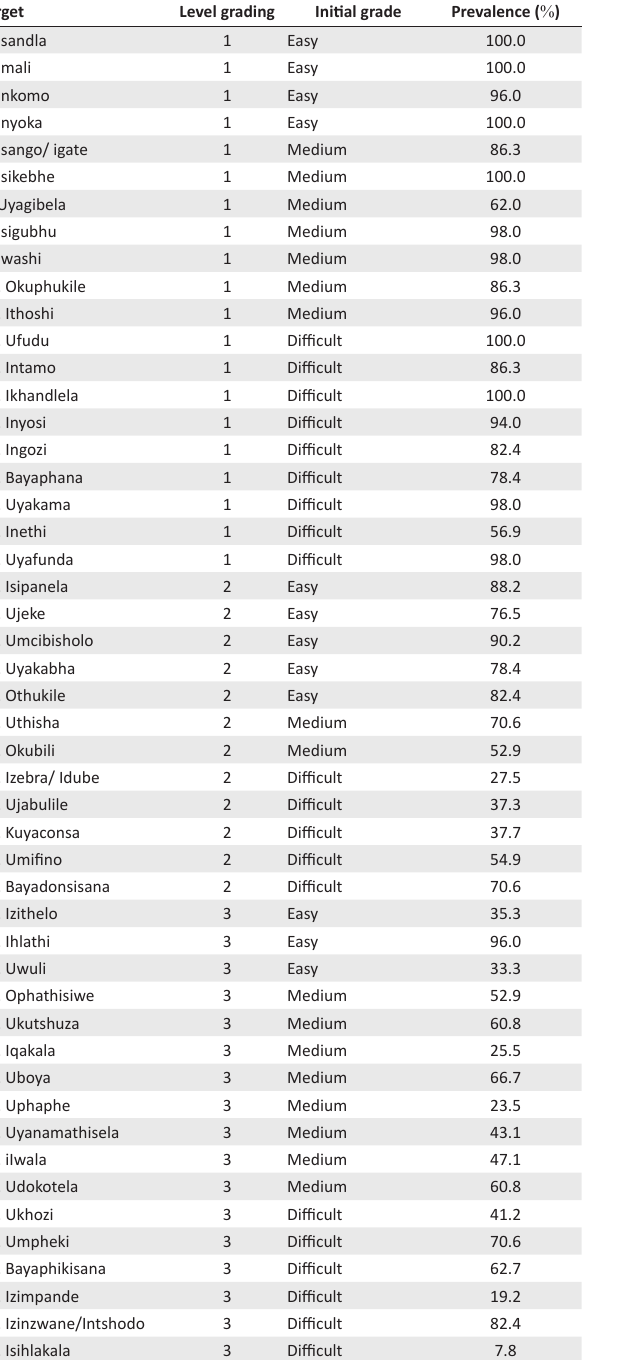
TABLE 1-A1: Ingwavuma receptive vocabulary scale form.